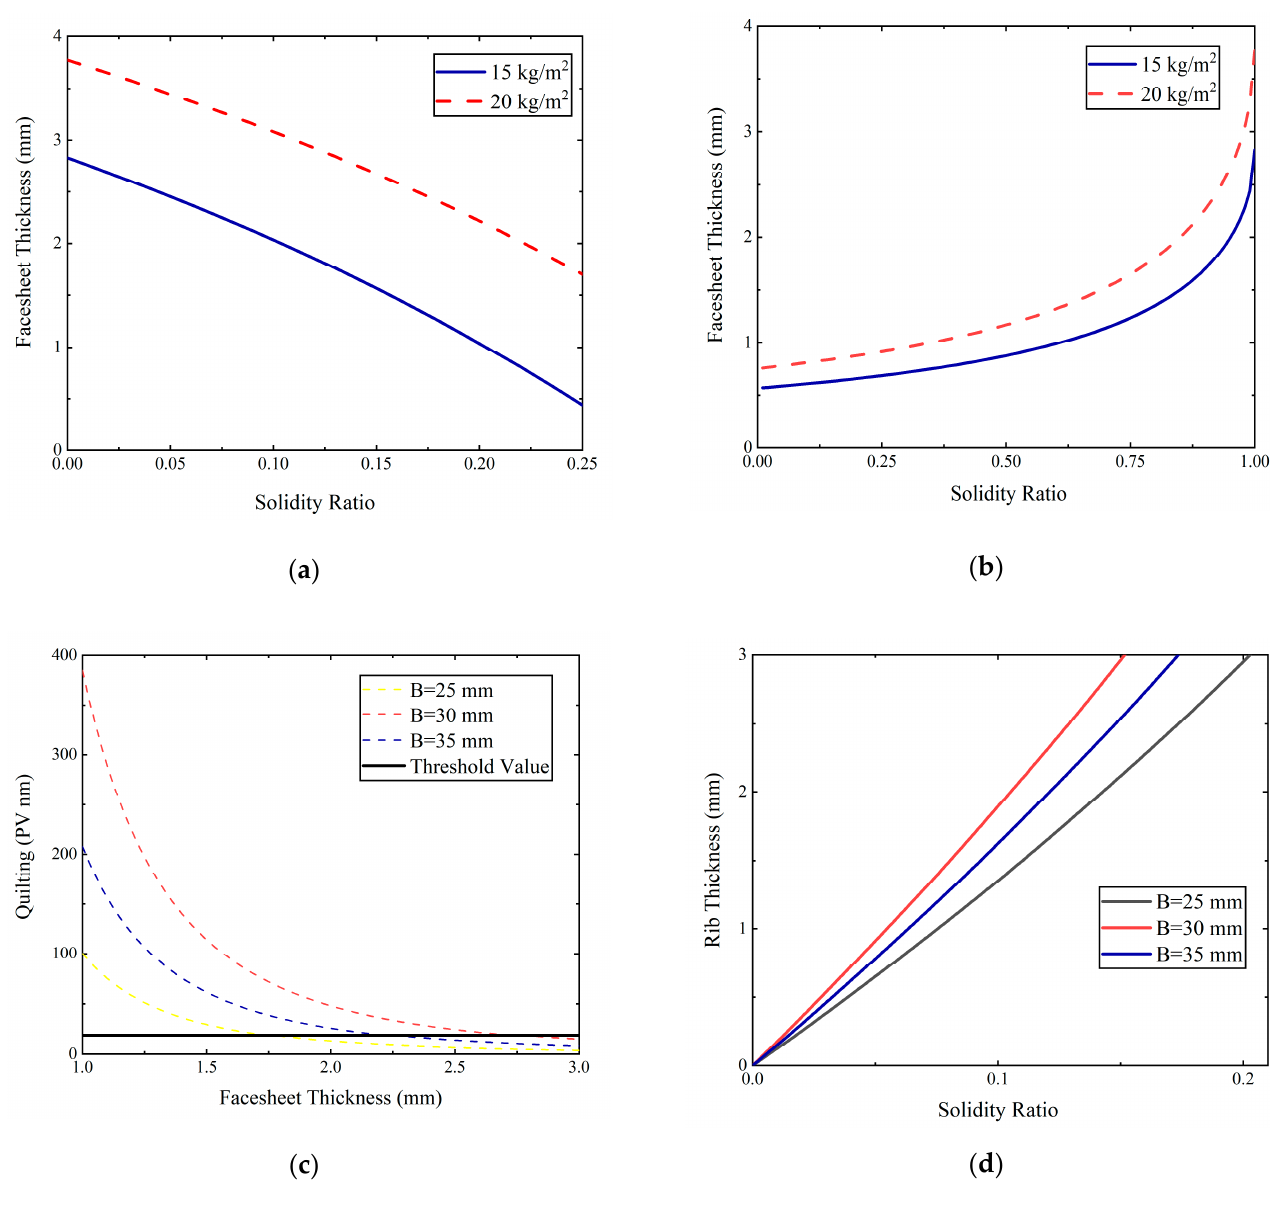
Figure 3. ( a ) Solidity ratio as a function of facesheet thickness. ( b ) Quilting deflection as a function of facesheet thickness. ( c ) Quilting deflection as a function of facesheet thickness. ( d ) Solidity ratio as a function of rib thickness.